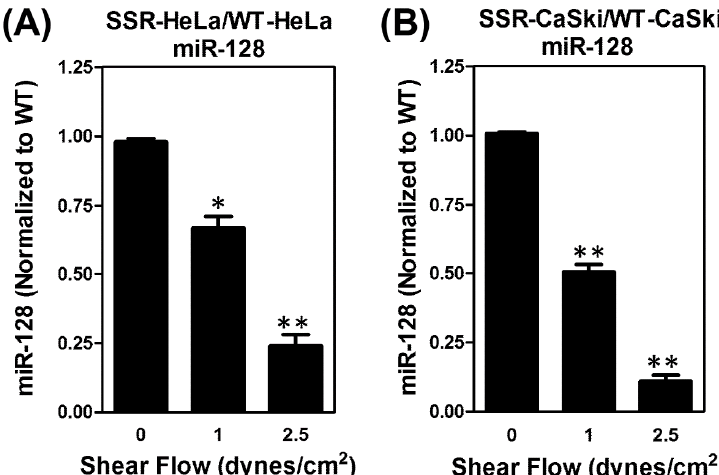
Figure 2. Suppression of miR-128 level in isolated WT and SSR cervical cancer cells as measured by parallel-plate flow chamber system. Isolated GFP-expressed WT or SSR cell populations (resistant to 0, 1, or 2.5 dynes/cm 2 shear flow) were sorted by cell sorter FACSAria™ III (BD Bioscience) to separate out HUVEC endothelial cells and we then extracted the total microRNA and expression levels of miR-128 through a quantitative RT-PCR analysis. Notably, consistent downregulation of miR-128 was shown for ( A ) SSR-HeLa and ( B ) SSR-CaSki cells clones in a shear stress-dependent manner. The data show the mean and standard deviation (SD) of three independent experiments using different batches of cells. * P < 0.05; ** P < 0.01 for the shear flow of 1 or 2.5 dynes/cm 2 group vs. control group.